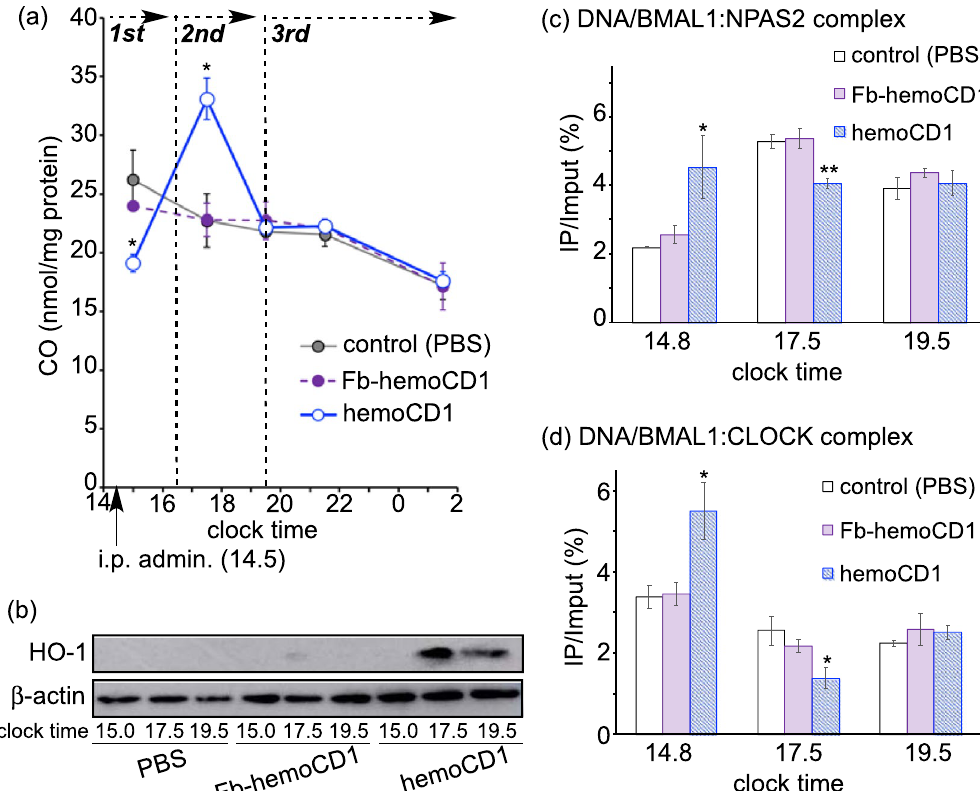
Figure 5. Quantification of CO, HO-1, and the DNA/protein complexes in the liver of the hemoCD1-treated mice. The mice were housed for two weeks under a 12 h light/dark (LD) cycle (lights on at 7:00 and light off at 19:00) until the day before the experiments. The mice were then housed under constant dark (DD) conditions during the observations. ( a ) Endogenous CO levels were measured by the assay using hemoCD1 35 . ( b ) HO-1 levels were ascertained by western blotting with an anti-HO-1 antibody at clock time 15.0 (first phase), 17.5 (second phase), and 19.5 (third phase). ( c , d ) ChIP assays were conducted using anti-NPAS2 and anti-CLOCK antibodies to measure the corresponding DNA complexes at clock time 14.8 (first phase), 17.5 (second phase), and 19.5 (third phase). PBS and Fb-hemoCD1 were used as controls. Each bar represents the mean ± SE ( n = 3 mice per group). Asterisk denotes statistical significance ( * P < 0.05, ** P < 0.01), as compared to the